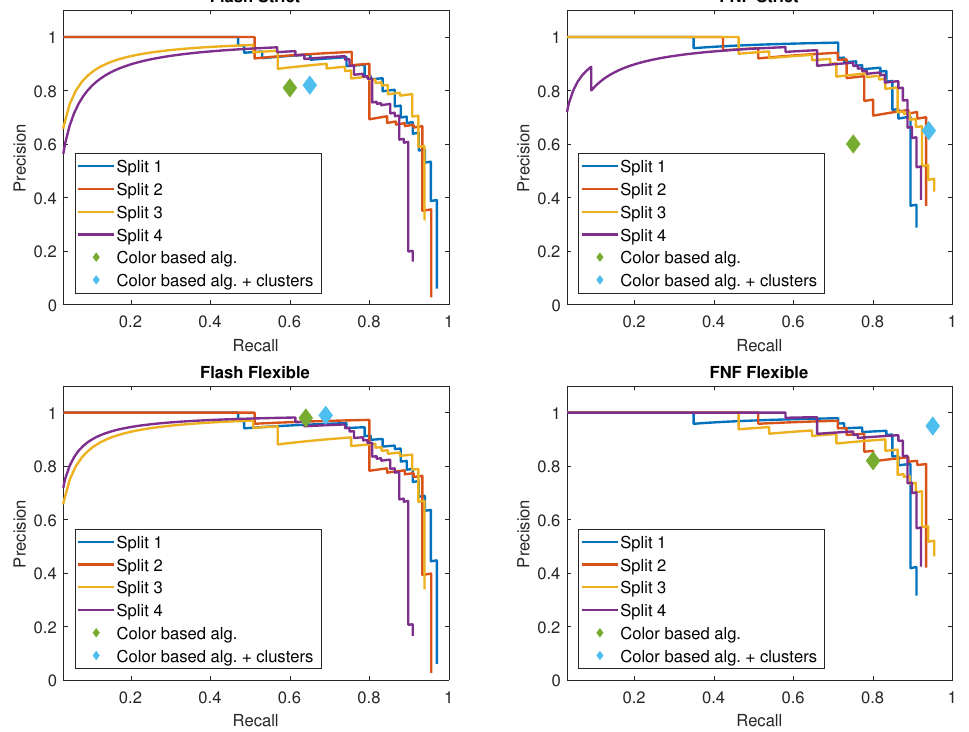
Figure 11. Precision-recall (PR) graph of the SSD object detection over each split of the Flash-only and FNF datasets. Color-based detection algorithm performance displayed for comparison. Figures depict: PR under the strict evaluation scheme for flash images ( top left ) and FNF images ( top right ), and PR under the flexible evaluation scheme for flash images ( bottom left ) and FNF images ( bottom right